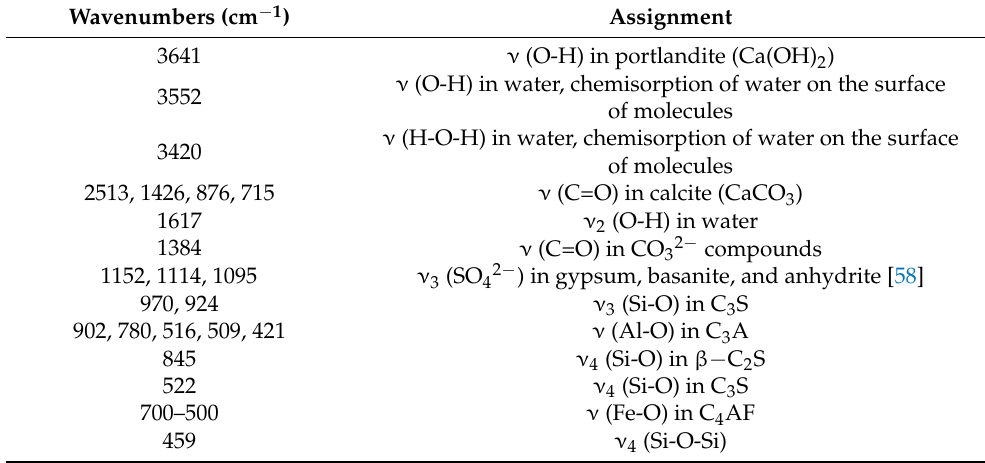
Table 3. Assignments of the major absorption bands of CEM I 42.5 R, Radot í n [57].